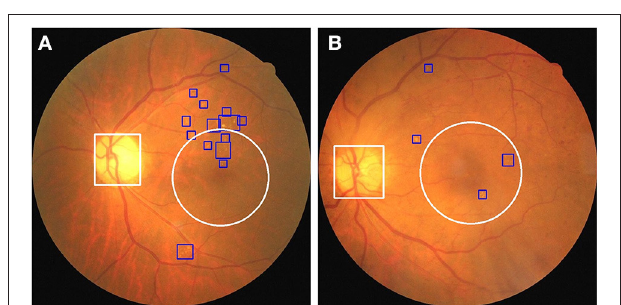
FIGURE 8 | The integration of the visualization of the optic disc and the macula in two fundus images with annotated HE lesions. (A) Fundus image from Figure 7A annotated with optic disc and macula. (B) Fundus image from Figure 7C annotated with optic disc and macula. HE lesions are represented as blue bounding boxes. The white circle represents 1DD from the macula center. The white bounding box represents the optic